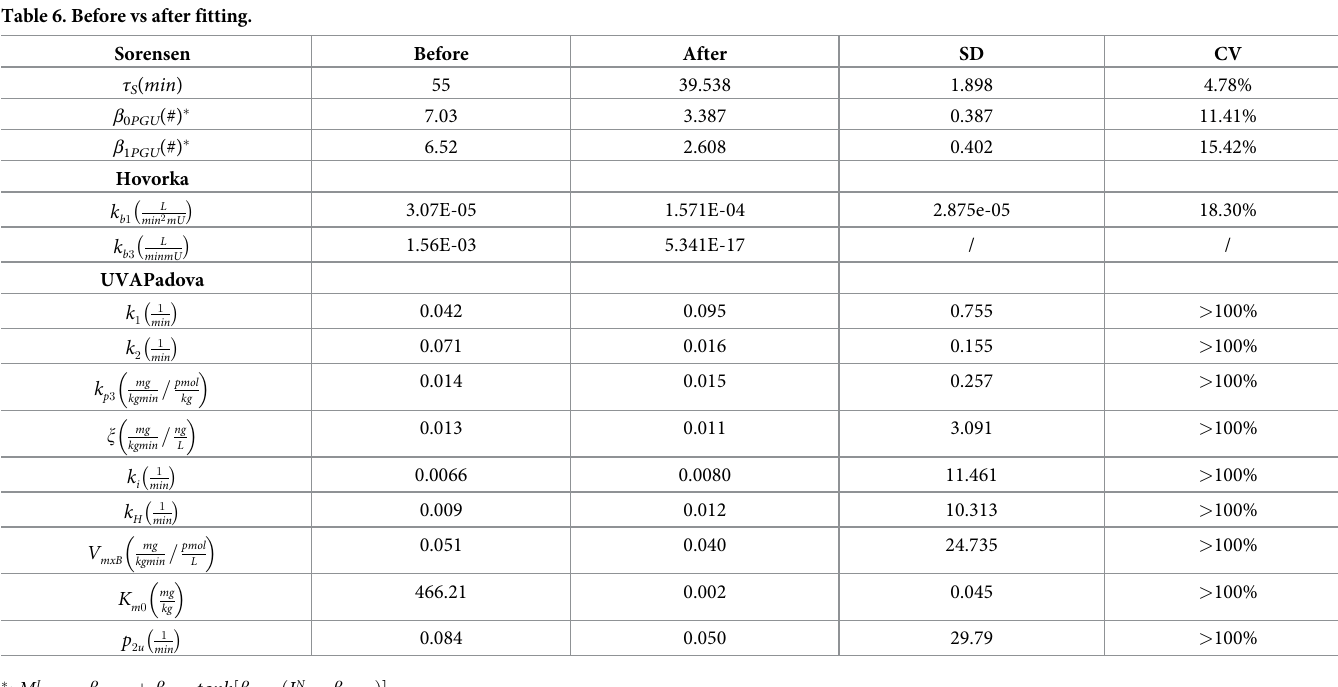
Table 6. Before vs after